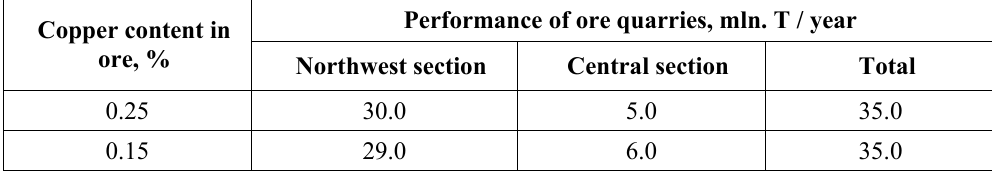
Table 3. Performance for the Extraction of Ore at the Mining Enterprise Erdenet, 2014 (made by the authors based on the data by LLC Erdenet, 2015) Performance of ore quarries, mln. T / Copper content in ore, %